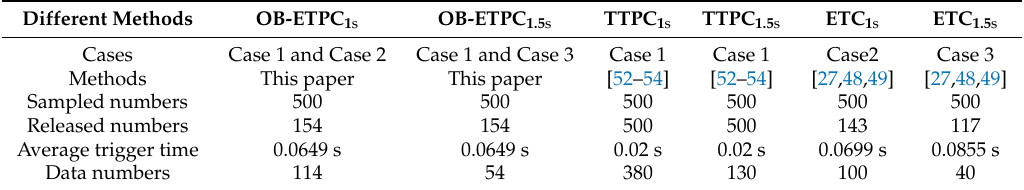
Table 2. Sampled numbers, released numbers, average trigger time and data numbers for three cases.